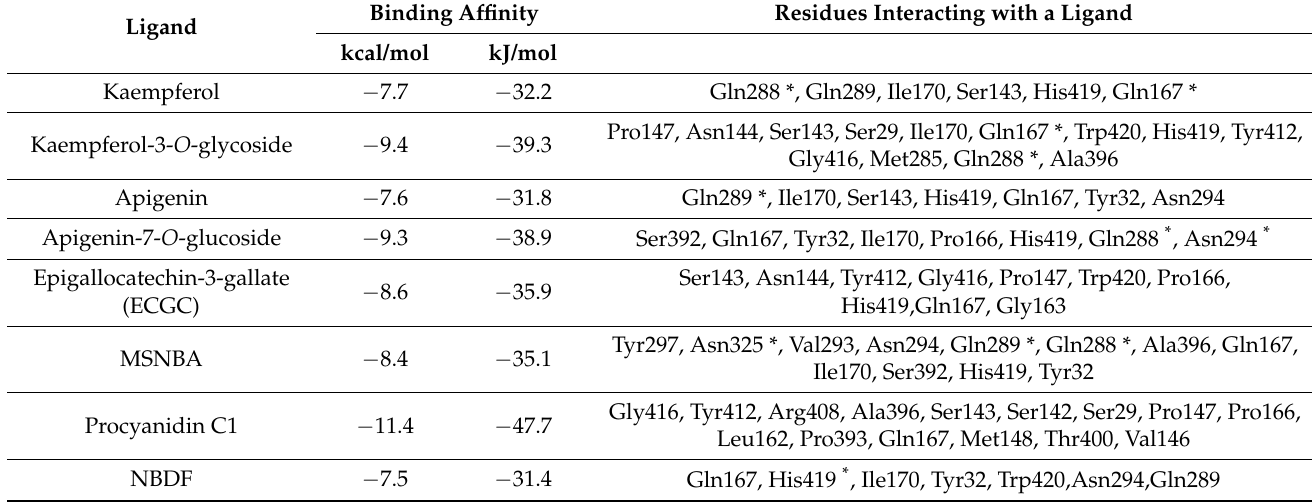
Table 3. Values of binding affinities and residues of GLUT5 in close contact with ligand: NBDF, MSNBA, and selected phenolic compounds identified in